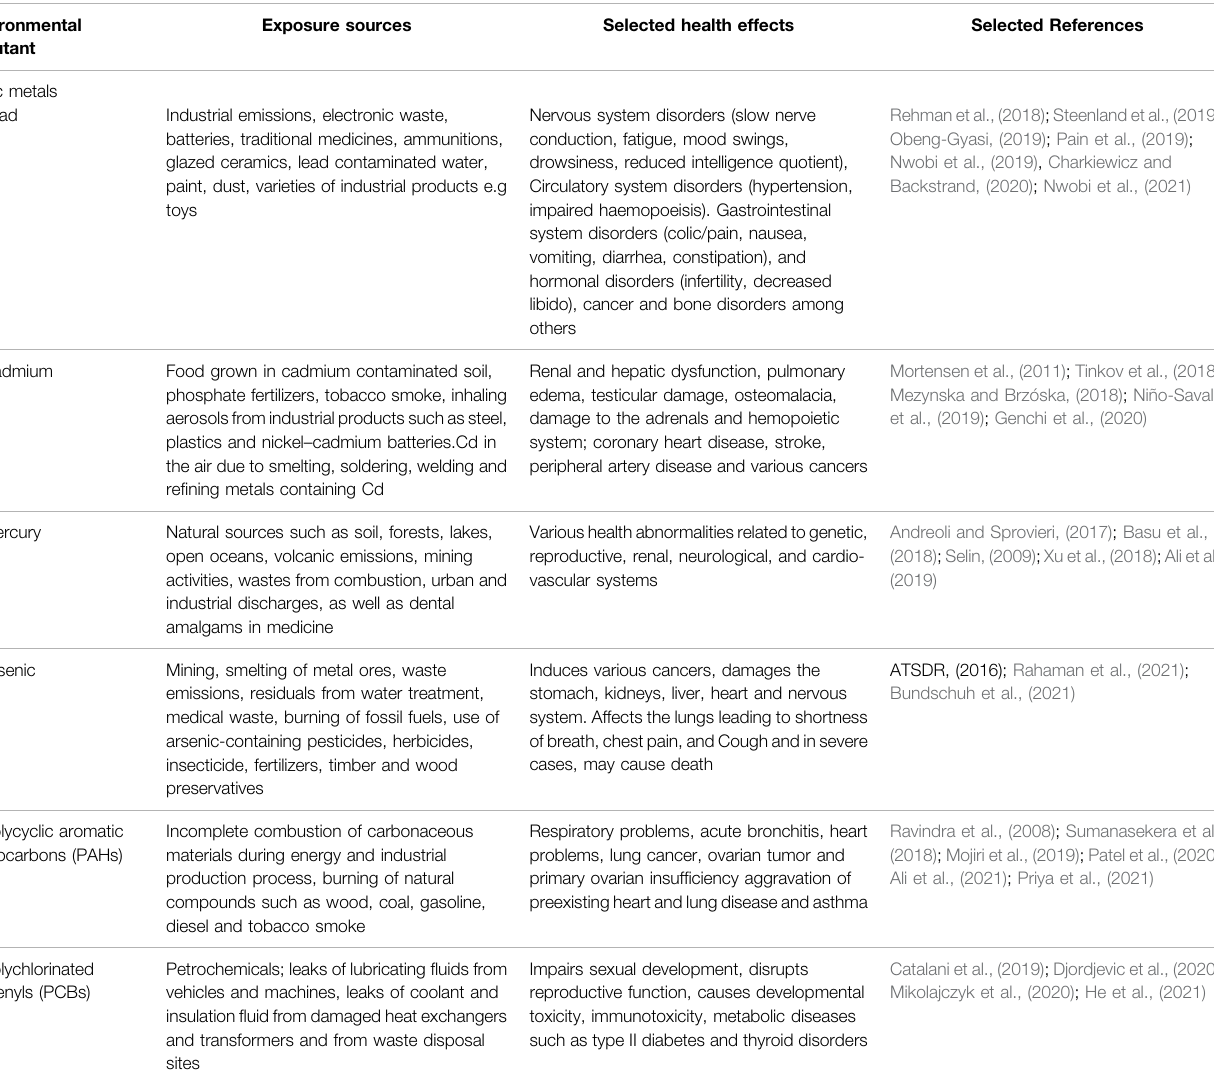
TABLE 1 | Major environmental pollutants, sources and associated health effects.